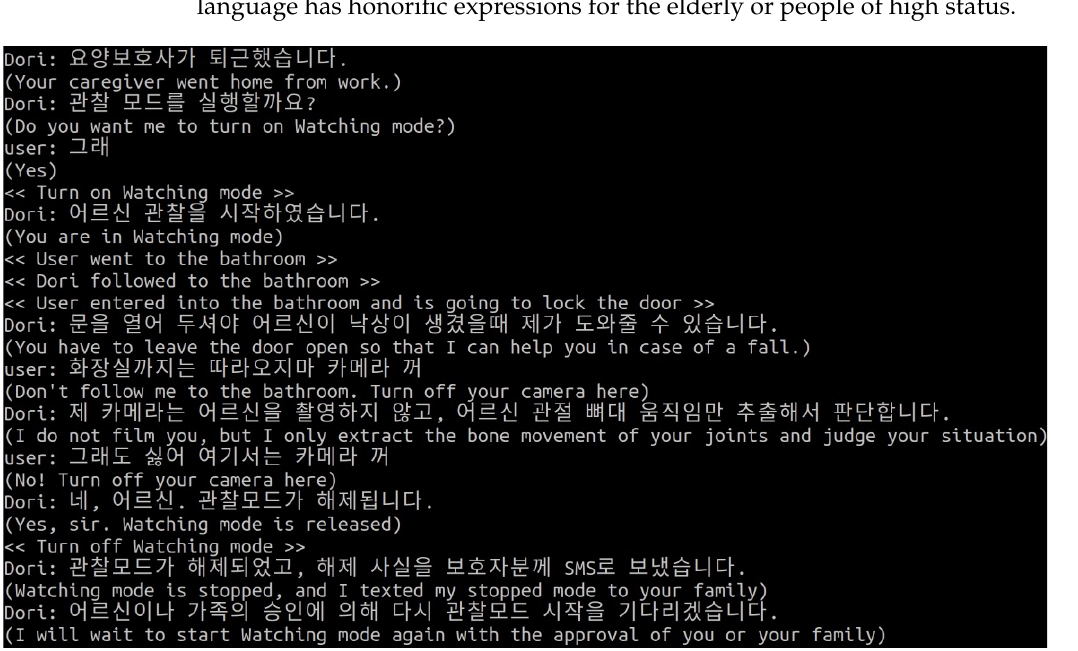
Figure 11. Example of a conversation between user and chatbot related to the second dilemma.